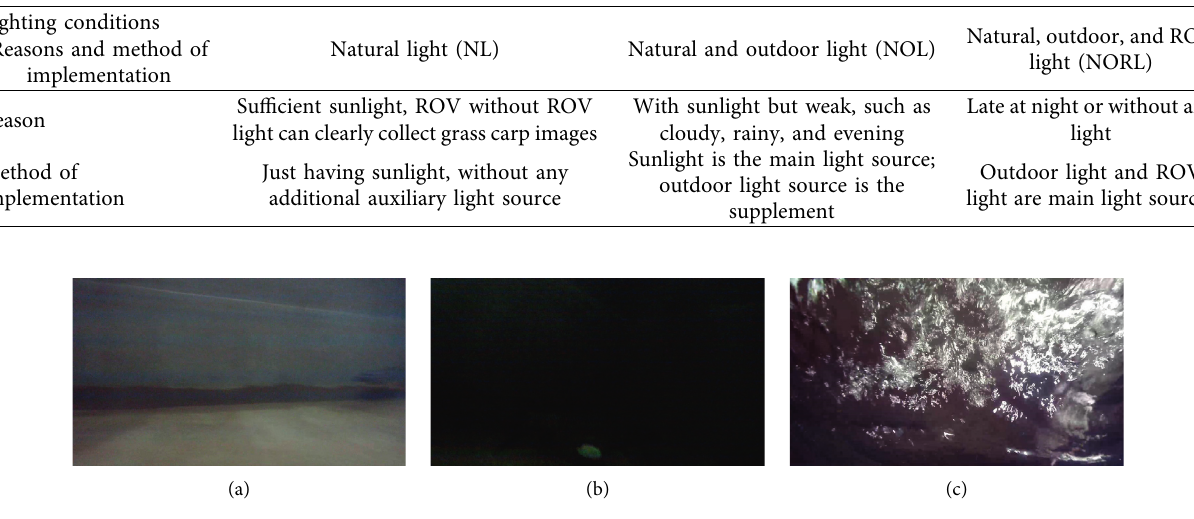
Figure 3: Cull images: (a) sports afterimage; (b) no target; (c) too many bubbles.